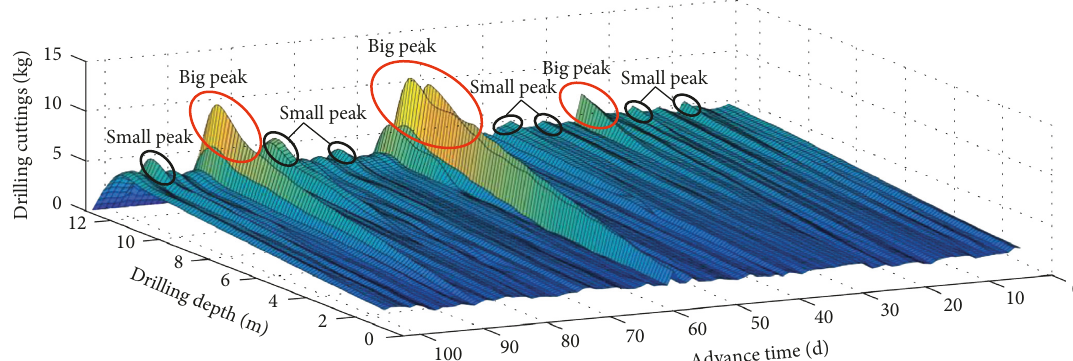
Figure 7: Relationship between the drilling cuttings and coalface advanced